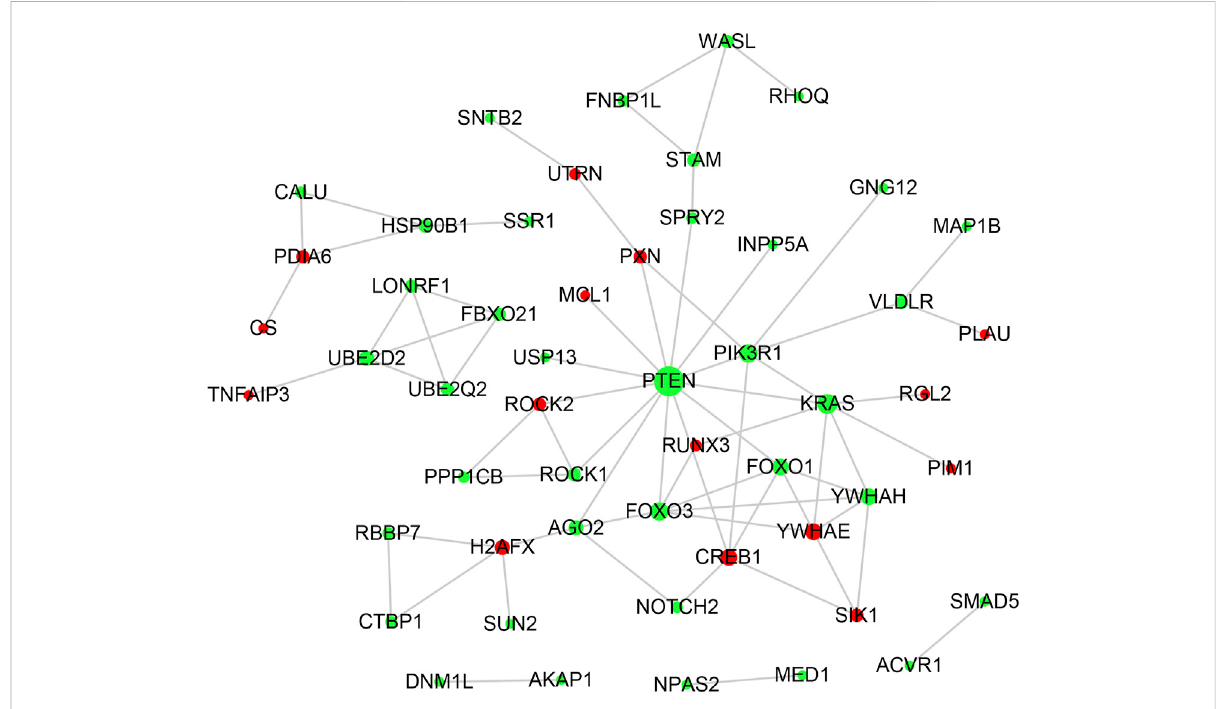
FIGURE 5 PPI network analysis. The PPI network consisting of 130 nodes and 61 edges was visualized in Cytoscape. Red and green notes symbolize the upregulated and downregulated genes. The size of each node is positively correlated with its degree